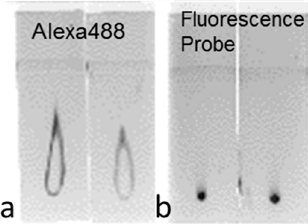
Figure 1. Although only the fluorescent tags ran on the TLC plates ( a ), fluorescent tags of Alexa488 were not separated from polyamidoamine-based functionalized silica nanoparticles (PCSNs) conjugated droplets on thin-layer chromatography (TLC) plates ( b ).